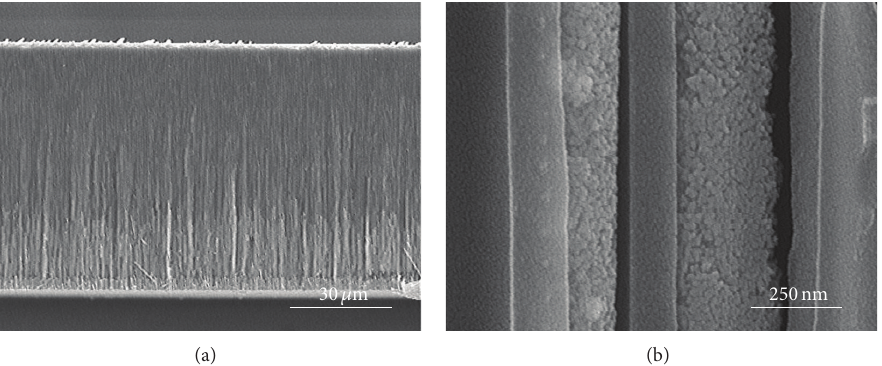
Figure 6: SEM micrographs of the ( Bi , Sb ) 2−𝑥 Te 3+𝑥 -based nanowires; the bias voltage was set at − 0.4 V, 𝑇 on /𝑇 off was 0.2 s/0.6s, and the electrolyte formula was 0.015 M Bi(NO 3 ) 3 -5H 2 O, 0.005 M SbCl 3 , and 0.0075 M TeCl 4 . (a) Side view with smaller ratio and (b) side view with larger ratio.